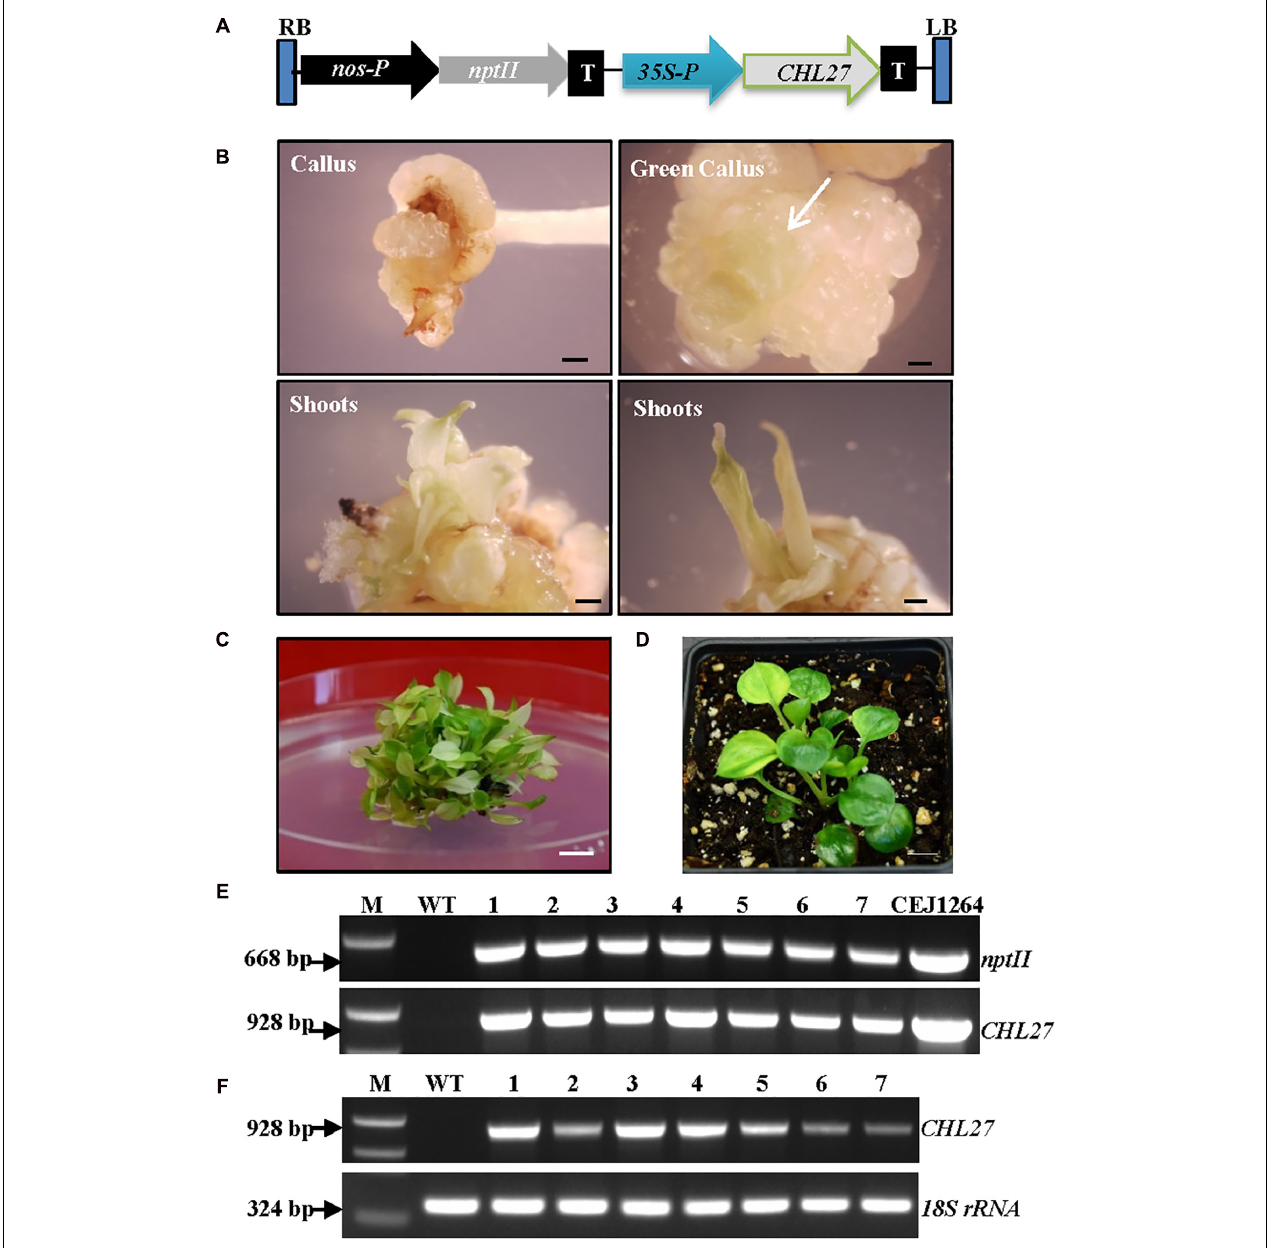
FIGURE 4 | Expression of CHL27 in albino plants. (A) Genetic cassette CEJ1264 with CHL27 driven by CaMV35S promoter (35S-P). The remaining annotations are the same as in Figure 2A . (B) Induced calli from petiole explant, and propagated green calli (white arrow) and shoots. Bar = 1 mm. (C) Mixed green and pale yellow shoots. Bar = 1 cm. (D) Regenerated green CHL27 transgenic plant. Bar = 1 cm. (E) Genomic DNA PCR and (F) RT-PCR of seven individual transgenic lines (1–7) amplified by specific primer pairs for nptII and CHL27 , respectively, using 18S rRNA as an internal control. M, molecular marker; WT, wild-type albino